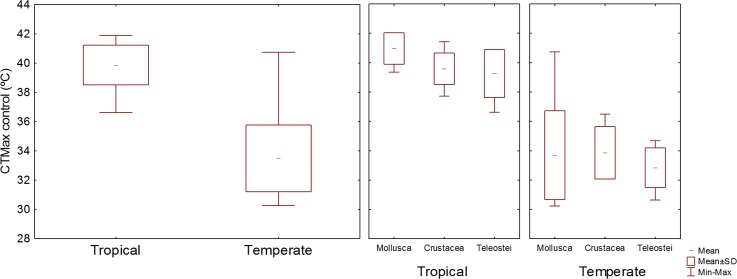
Distribution of the values of CTMaxcontrol of tropical and temperate organisms.